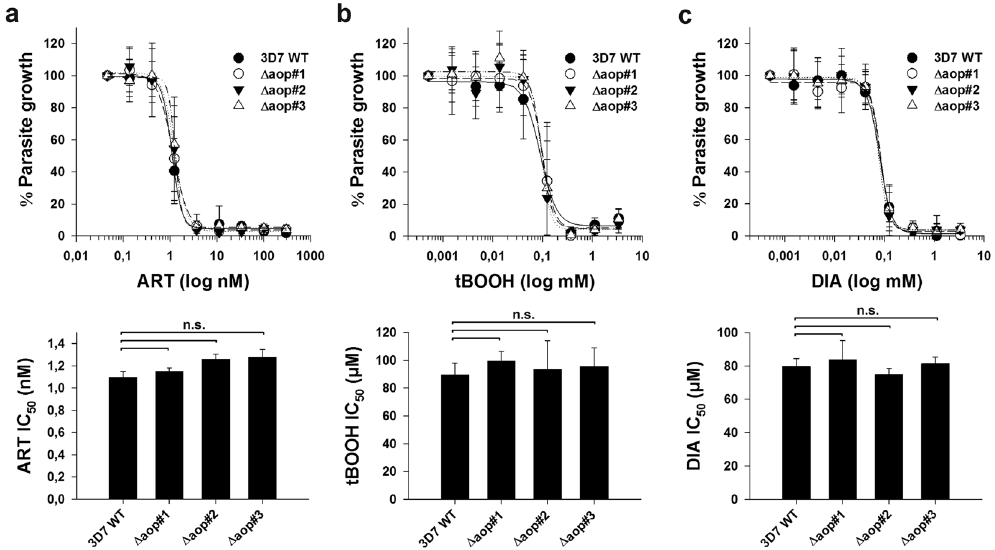
Figure 6. IC 50 values for artemisinin and oxidants of Δ pfaop knockout parasites. ( a ) Artemisinin dose- response curves (upper panel) and IC 50 values (lower panel) of blood stage cultures of strains Δ aop#1-3 from Fig. 4. (b,c) tBOOH and diamide (DIA) dose-response curves (upper panel) and IC 50 values (lower panel). All data are the mean ± standard deviation of at least three independent triplicate measurements. Wild type